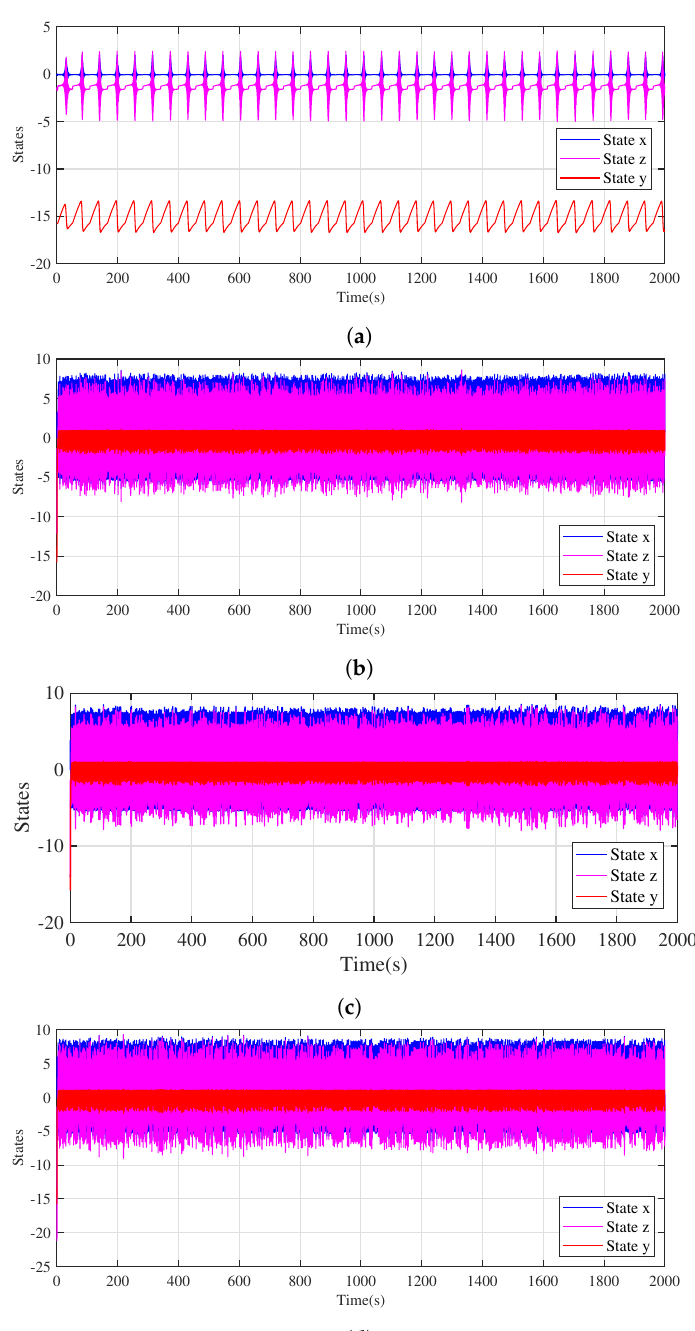
Figure 4. Time series of states x , y and z of the non-optimized and optimized fractional-order chaotic systems presented in Table 1: ( a ) non-optimized; ( b ) DE-optimized; ( c ) PSO-optimized; ( d )